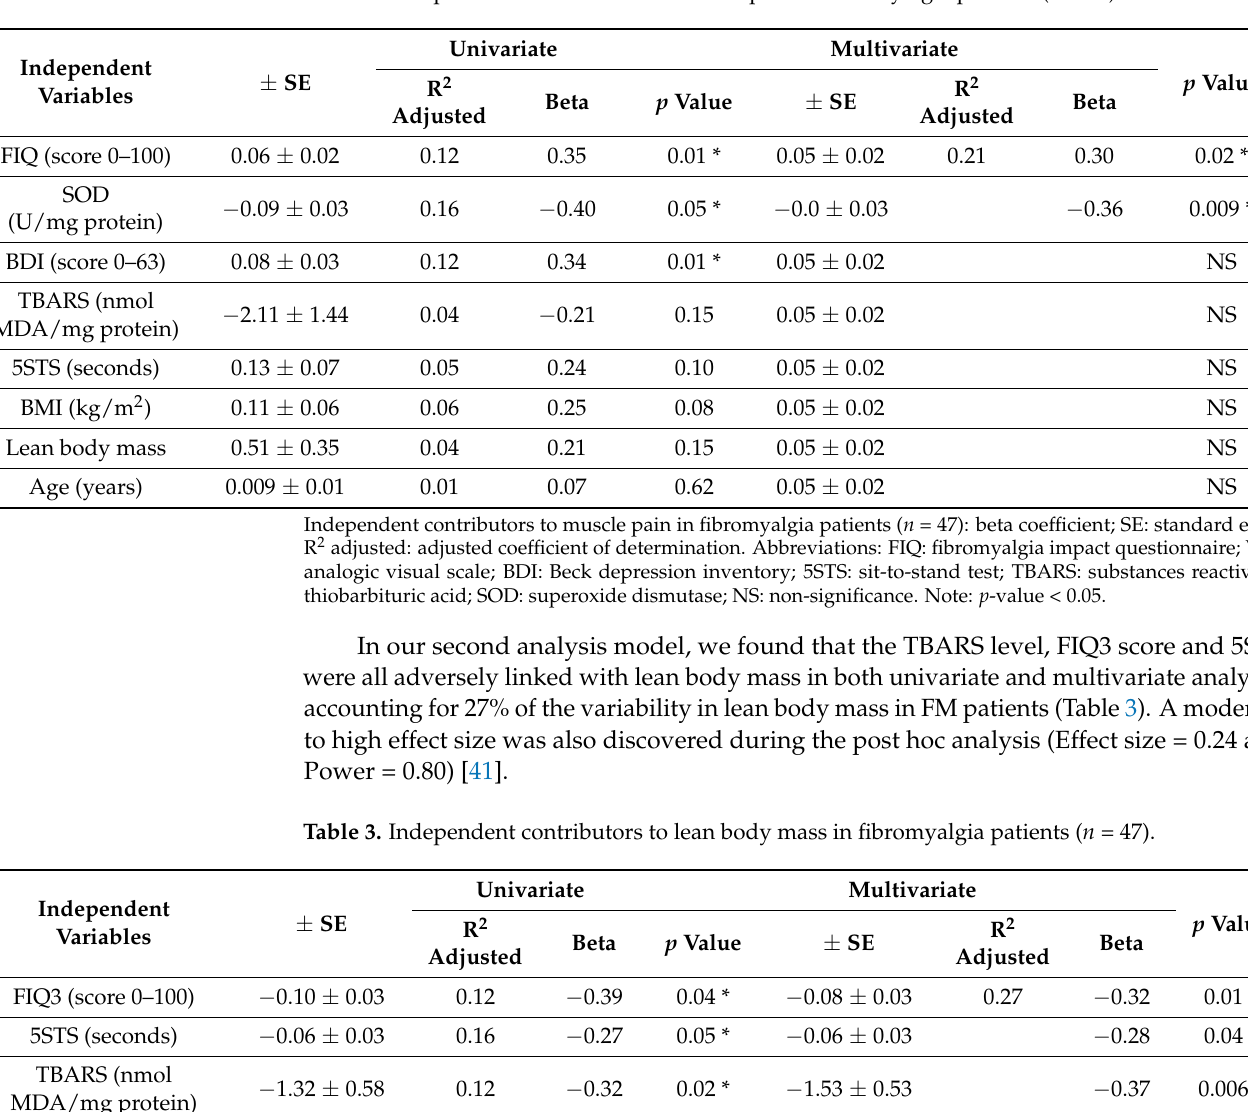
Table 2. Independent contributors to muscle pain in fibromyalgia patients ( n = 47).